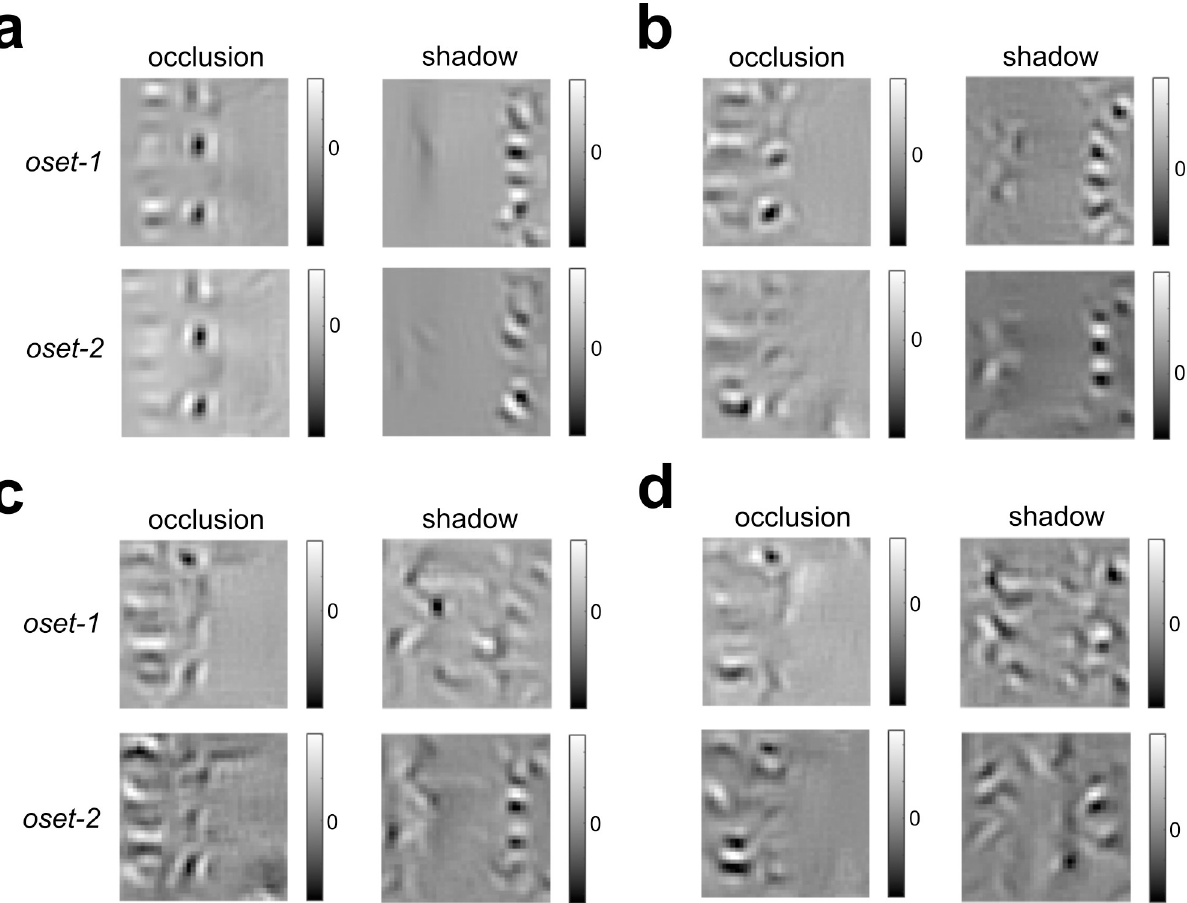
Fig 5. Stimuli that maximize + minimize the occlusion probability predicted by the GFB and FRF models trained to distinguish shadows from occlusions (oset-1, oset-2). ( a ) Left : Stimuli obtained via numerical optimization with highest predicted occlusion probability by the GFB model. We see consistent results for both training sets, over multiple optimizations. Right : Same as left column, but with highest predicted shadow probability by the GFB model (equivalently, lowest predicted occlusion probability). ( b ) Same as (a) but for FRF-4 . ( c ) Same as (a) but for FRF-6 . ( d ) Same as (a) but for FRF-10